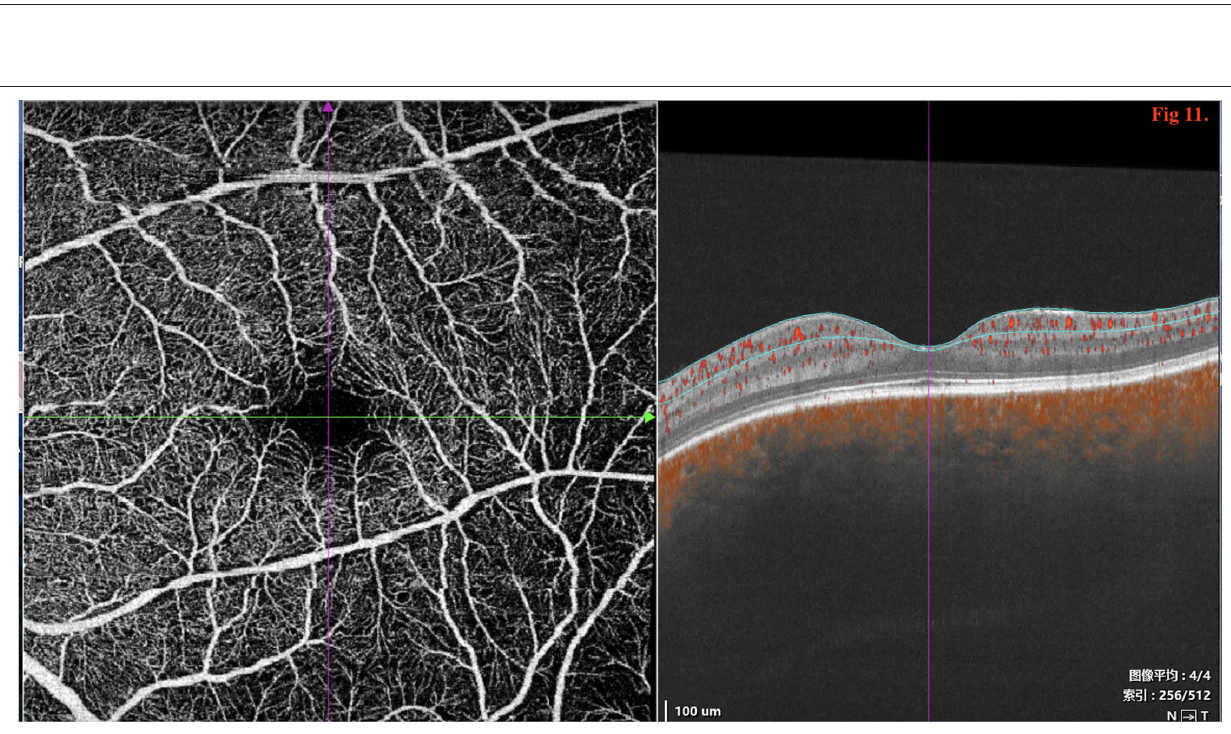
Frontiers in Medicine |